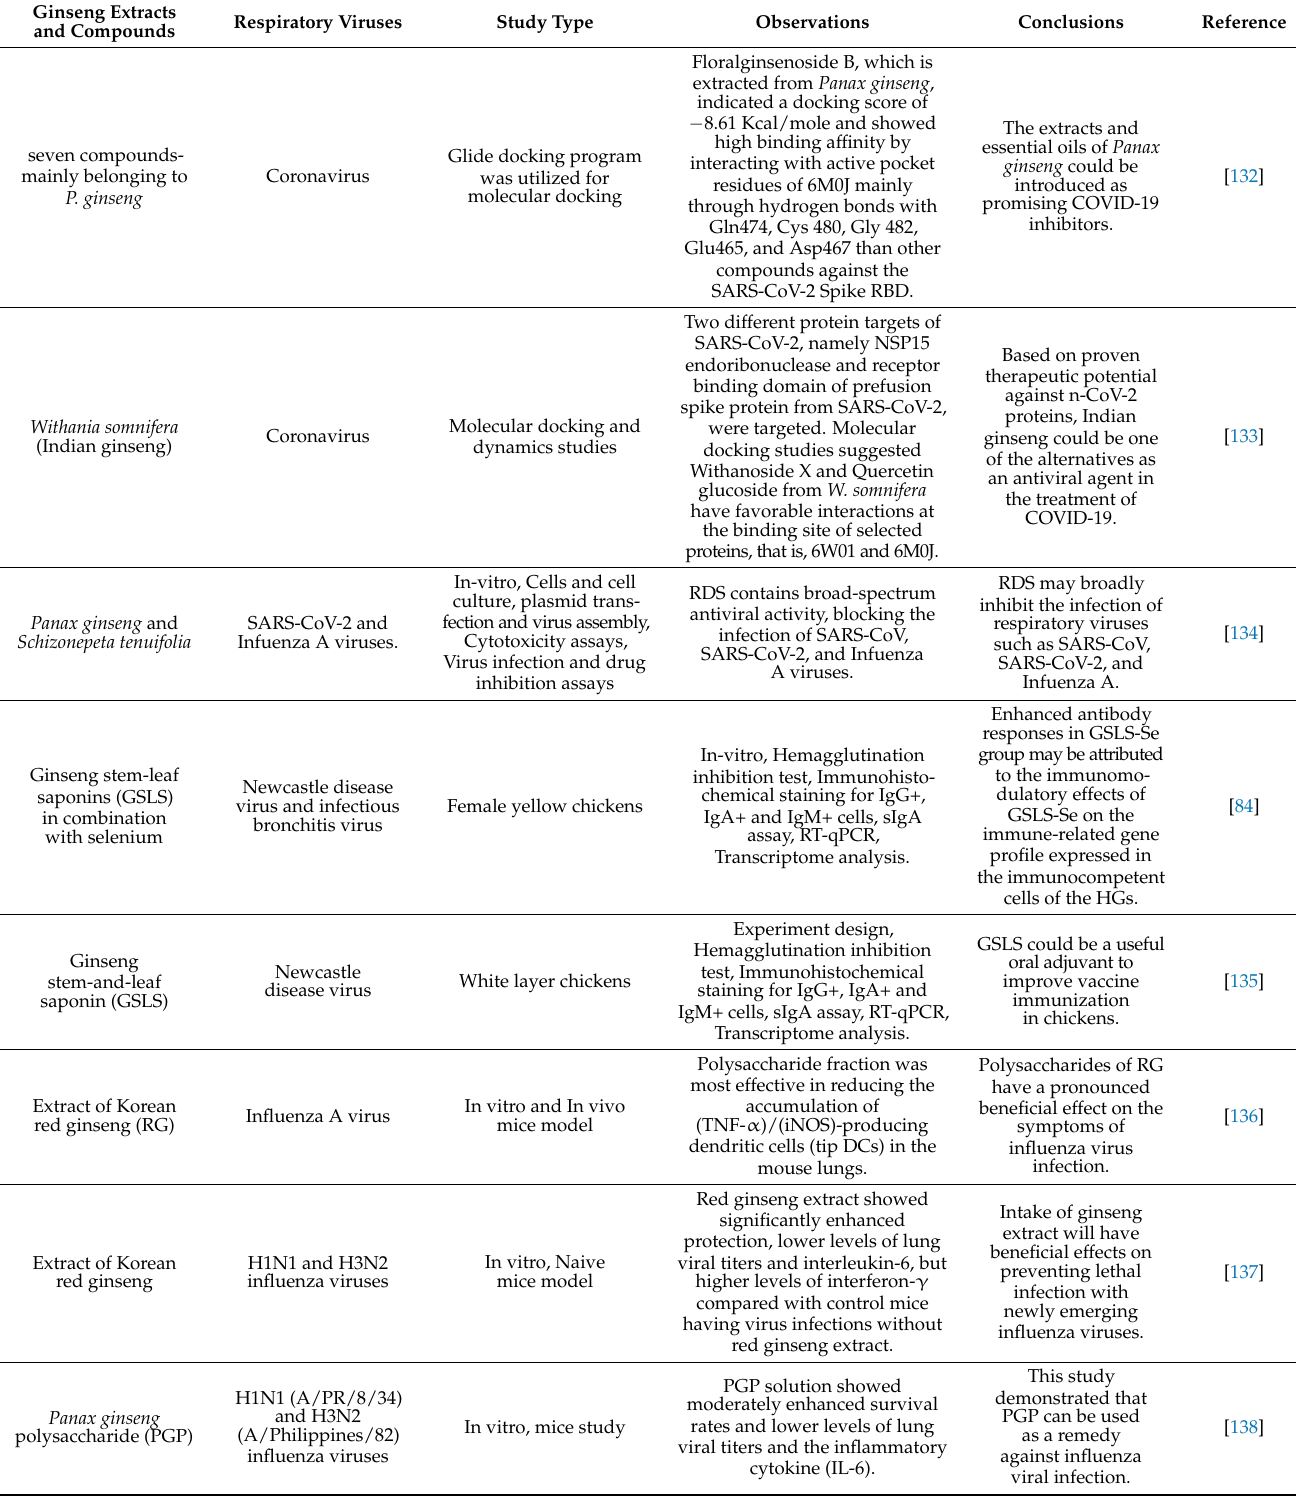
Table 1. Effects of ginseng on different respiratory viruses’